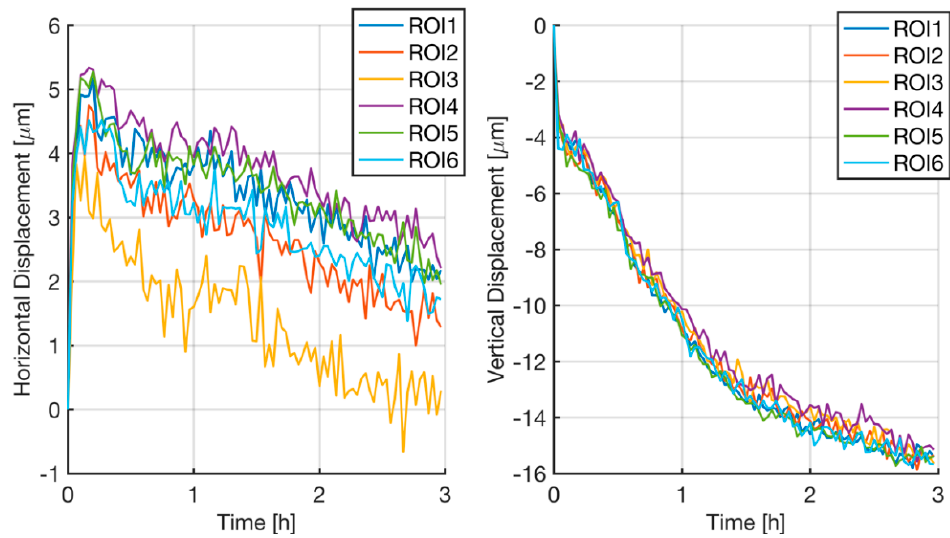
Figure 8. The measured horizontal (left) and vertical (right) shifts for a static dry experiment for each ROI. The results are shown for sample 1, but similar graphs were obtained for all the measured samples.